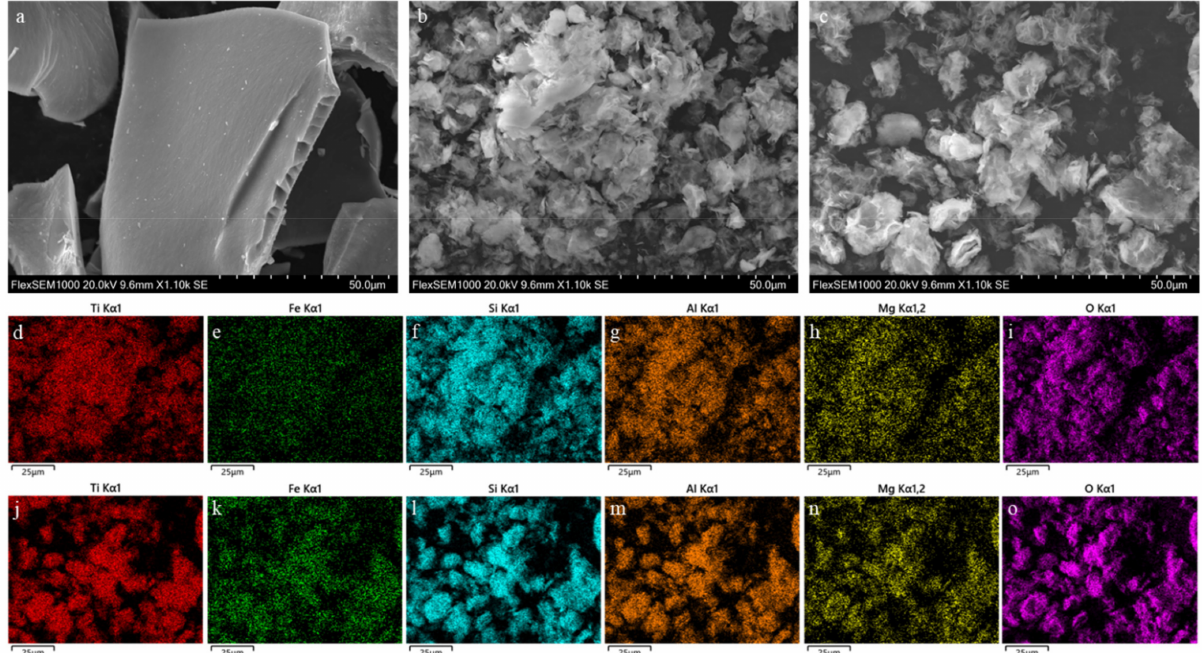
Figure 3. SEM images of: ( a ) TiO 2 ; ( b ) Fe/Mt/TiO 2 ; and ( c ) x Fe-Mt/(1 − x )Fe-TiO 2 . SEM-EDX K α maps of: ( d ) titanium; ( e ) iron; ( f ) silica; ( g ) aluminum; ( h ) magnesium; and ( i ) oxygen for Fe/Mt/TiO 2 . SEM-EDX K α maps of: ( j ) titanium; ( k ) iron; ( l ) silica; ( m ) aluminum; ( n ) magnesium; and ( o ) oxygen for x Fe-Mt/(1 − x )Fe-TiO 2 . Scale bars were adjusted to be the same and indicate 50.00 µ m.